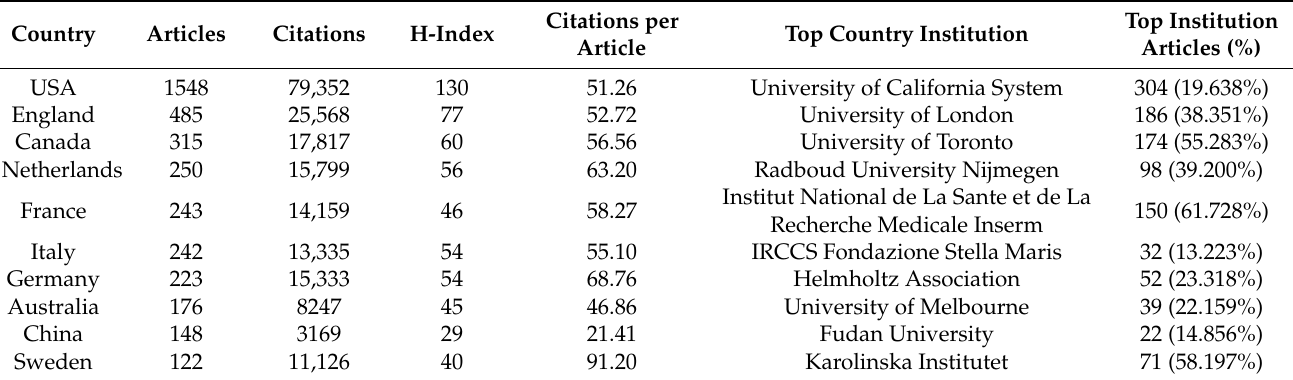
Figure 4. Geographical distribution of genetic factors in ASD publications. Table 1. Top countries and country institutions for autism genetics research.